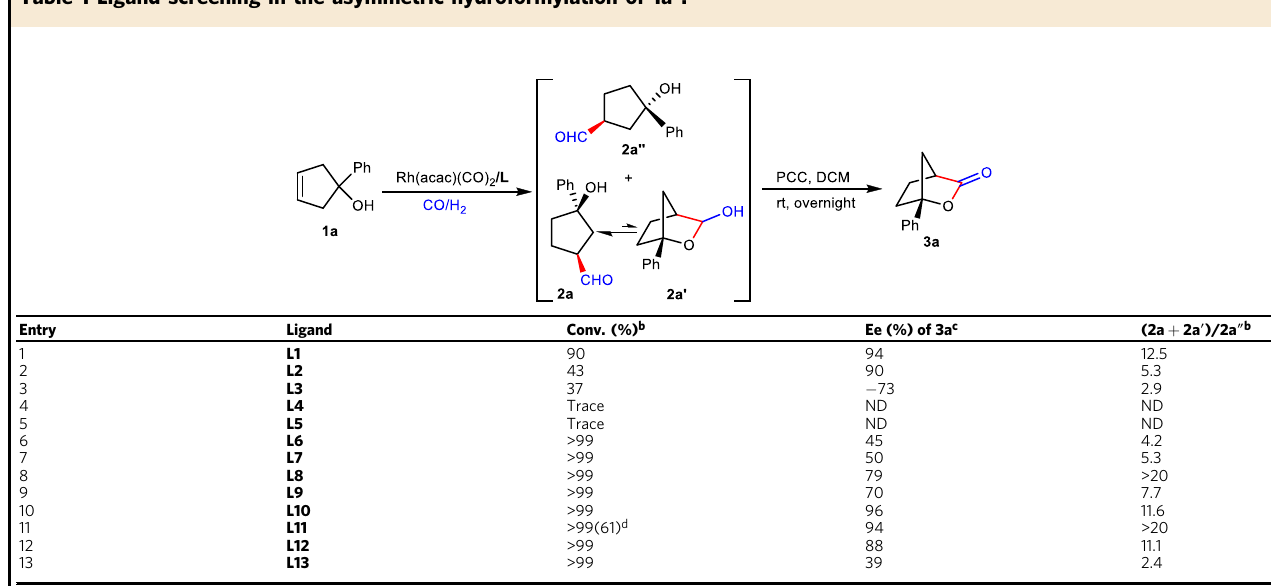
Table 1 Ligand screening in the asymmetric hydroformylation of 1a a